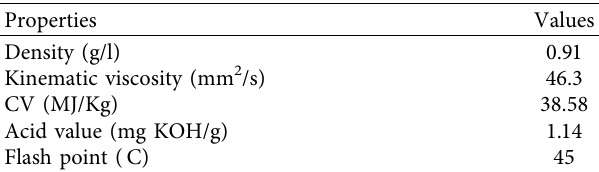
Table 1: Properties of fat